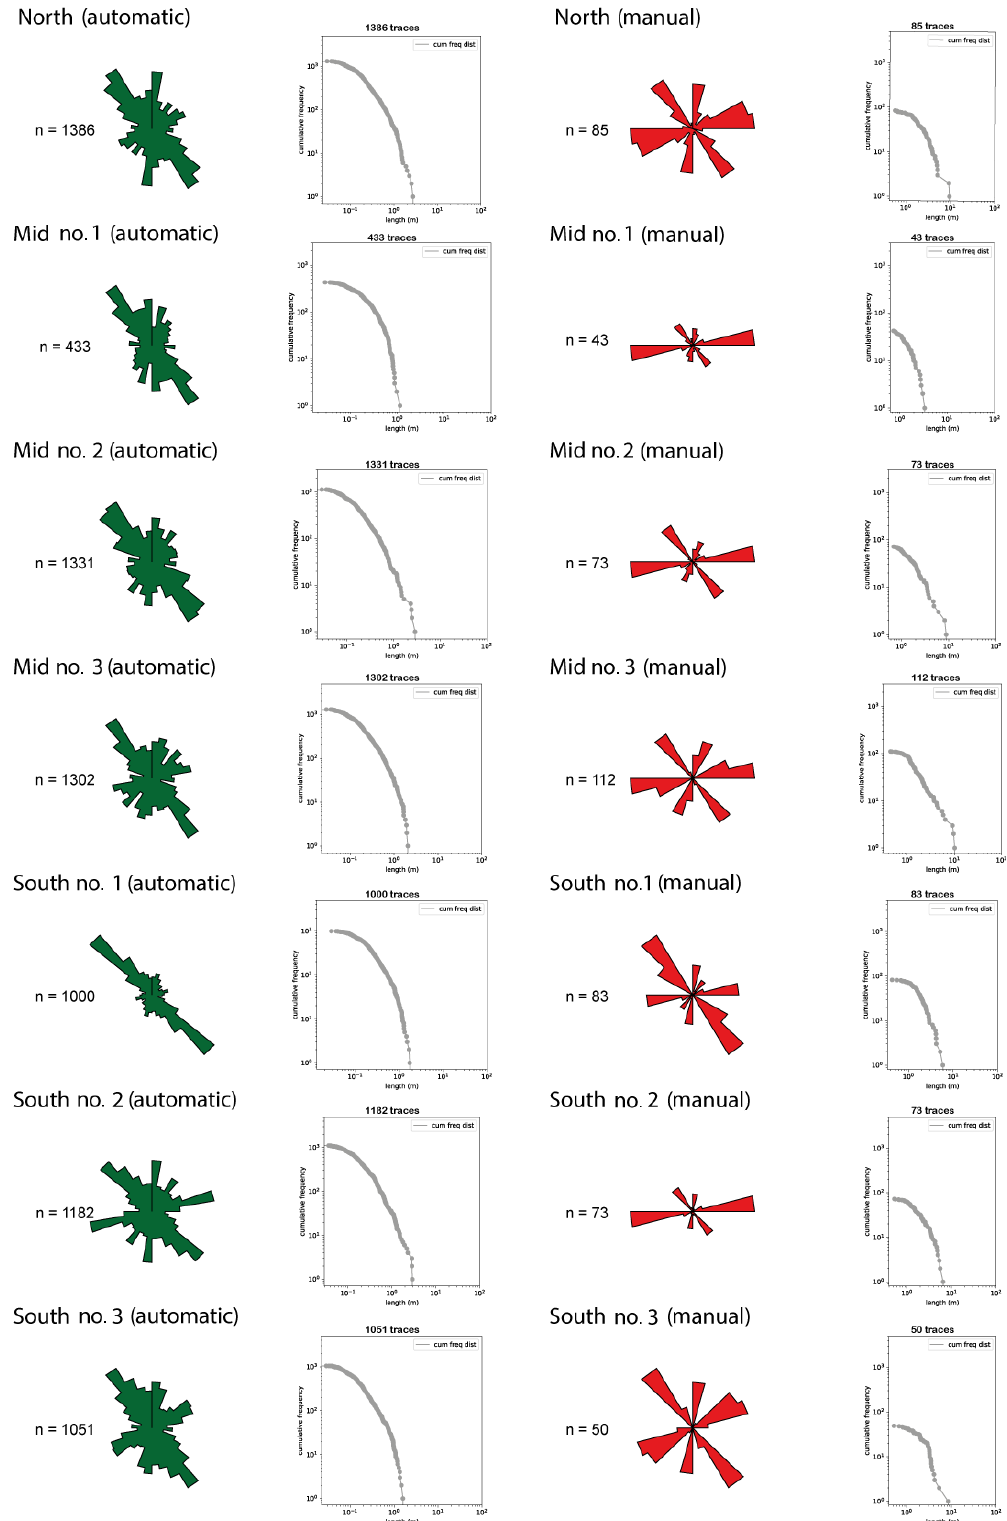
Figure 13. Comparison of trace length-weighted rose plots and cumulative trace length distributions for automatic and manual trace inter- pretations from Brejões outcrop stations. The Brejões dataset (Prabhakaran et al., 2019a) is available under a CC-BY-NC-SA license.